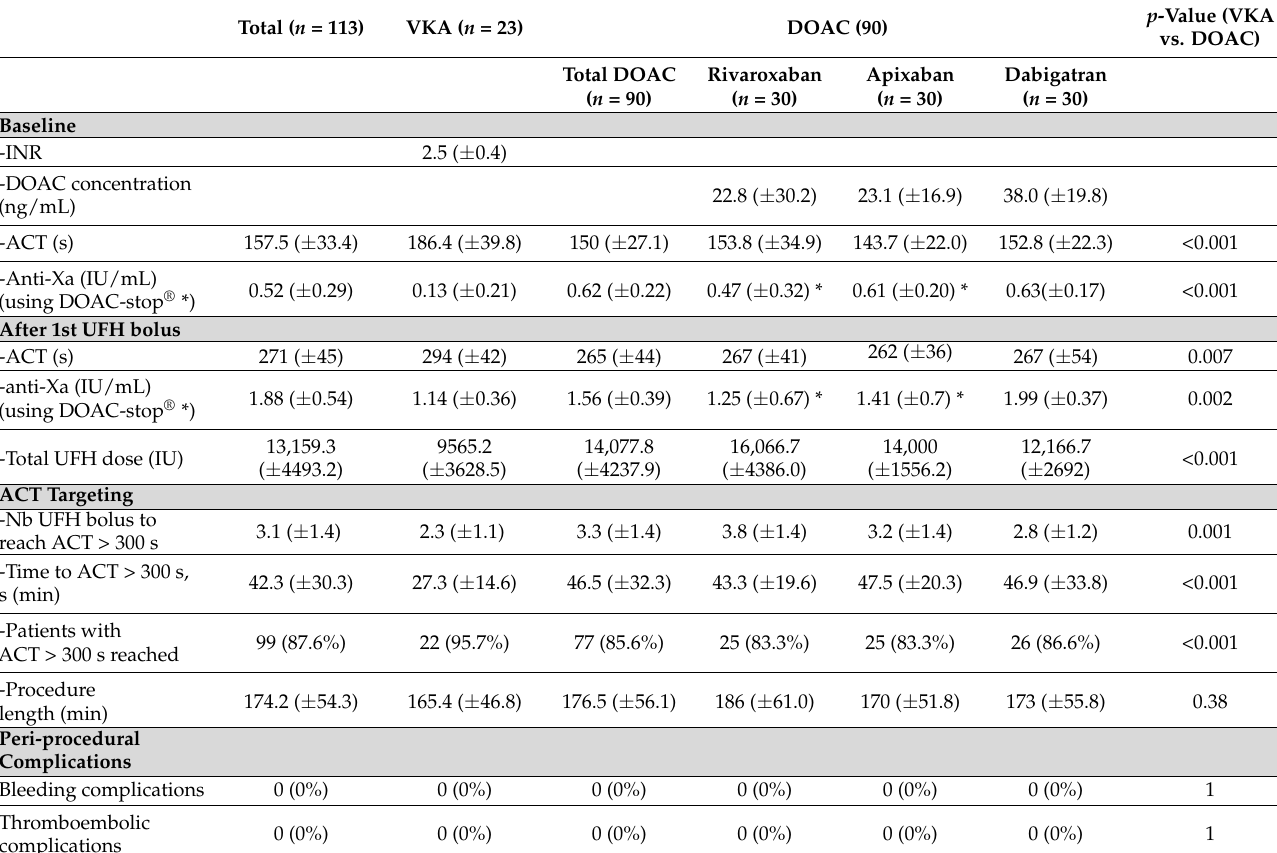
Table 2. Procedural characteristics. Continuous variables are expressed by mean and standard deviation (SD) and categorical variables by percentages. *: use of DOAC-stop ® in the blood sample.